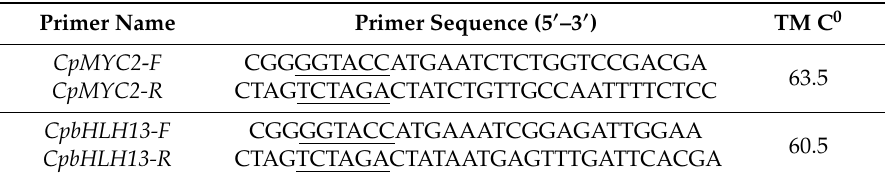
Table 5. Primers of the candidate genes used for PCR